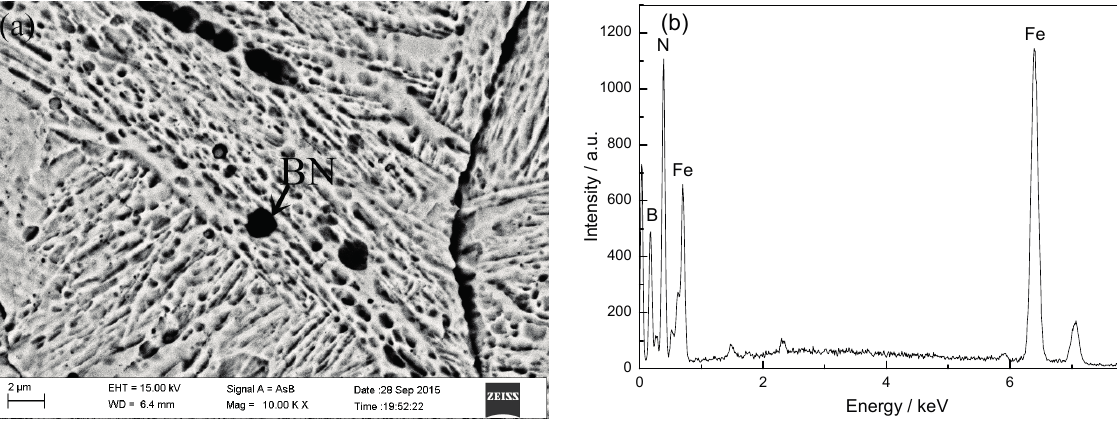
Figure 4. SEM morphology of BN precipitate ( a ) and EDS spectrum; ( b ) in steel